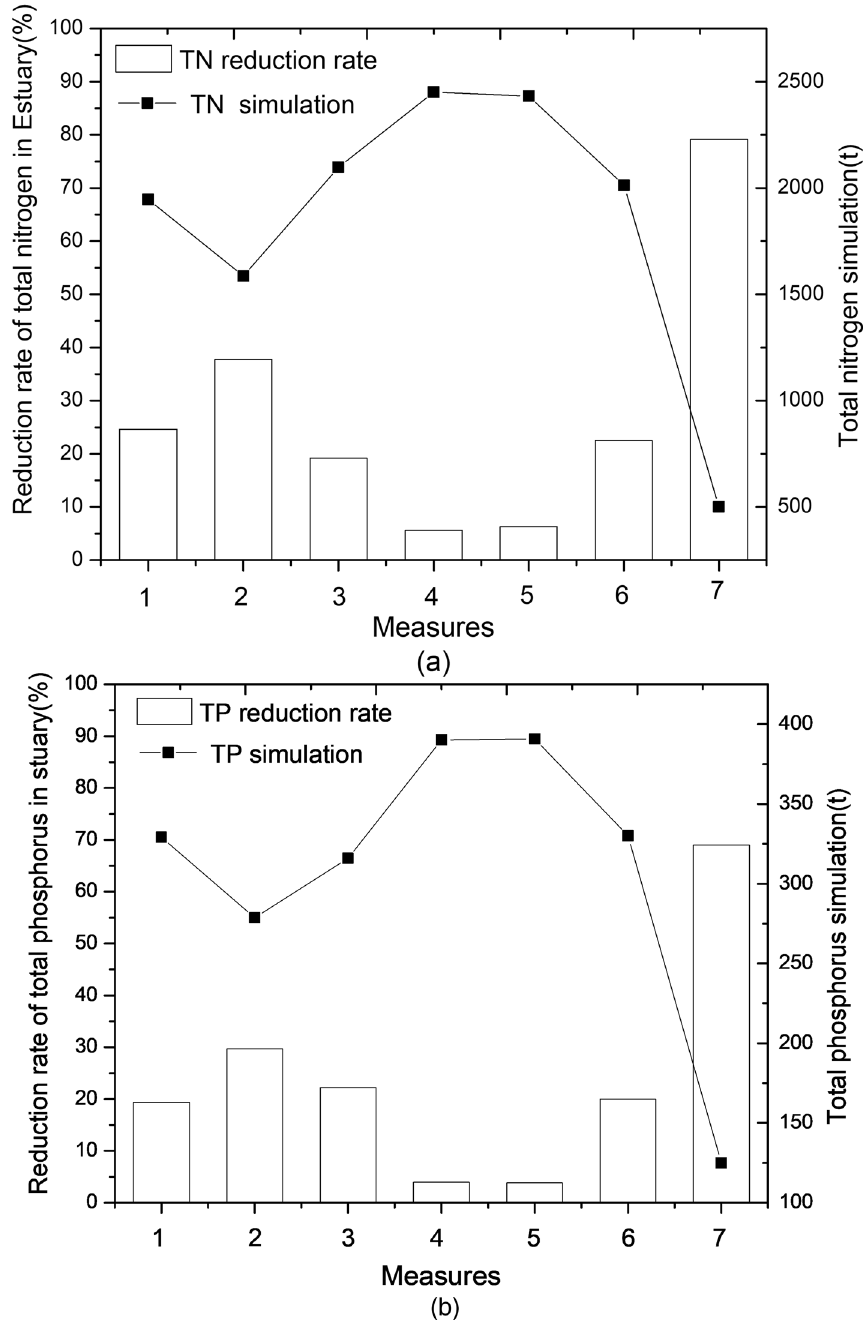
Fig. 11 Reduction of total nitrogen and phosphorus emis- sions under different measures: a TN, b